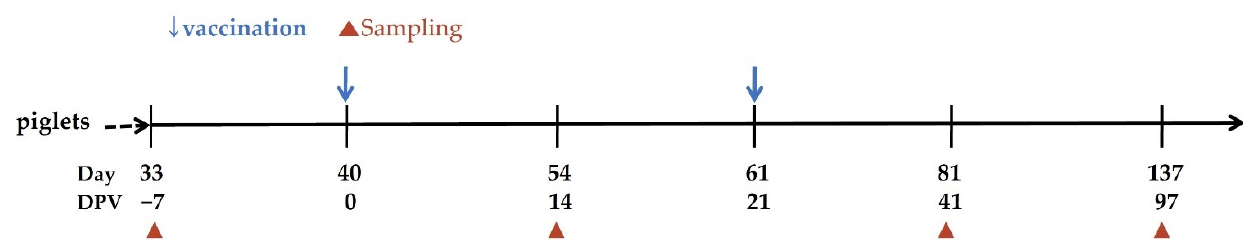
Figure 2. The schematic presentation of immunization protocol in the suburb of Pohang. The timing of blood collection and sampling from the piglets was presented.